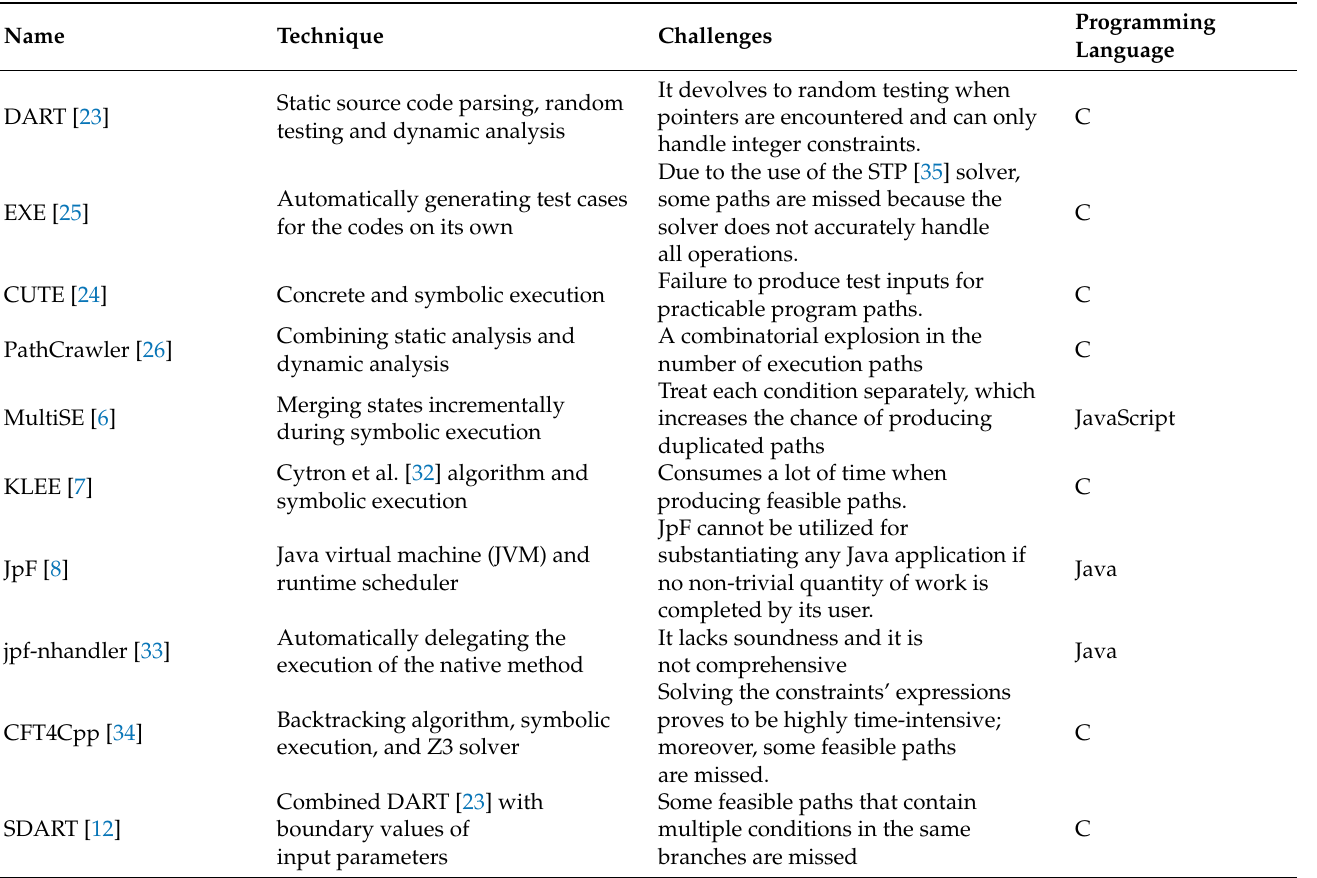
Table 1. Symbolic execution studies to detect feasible